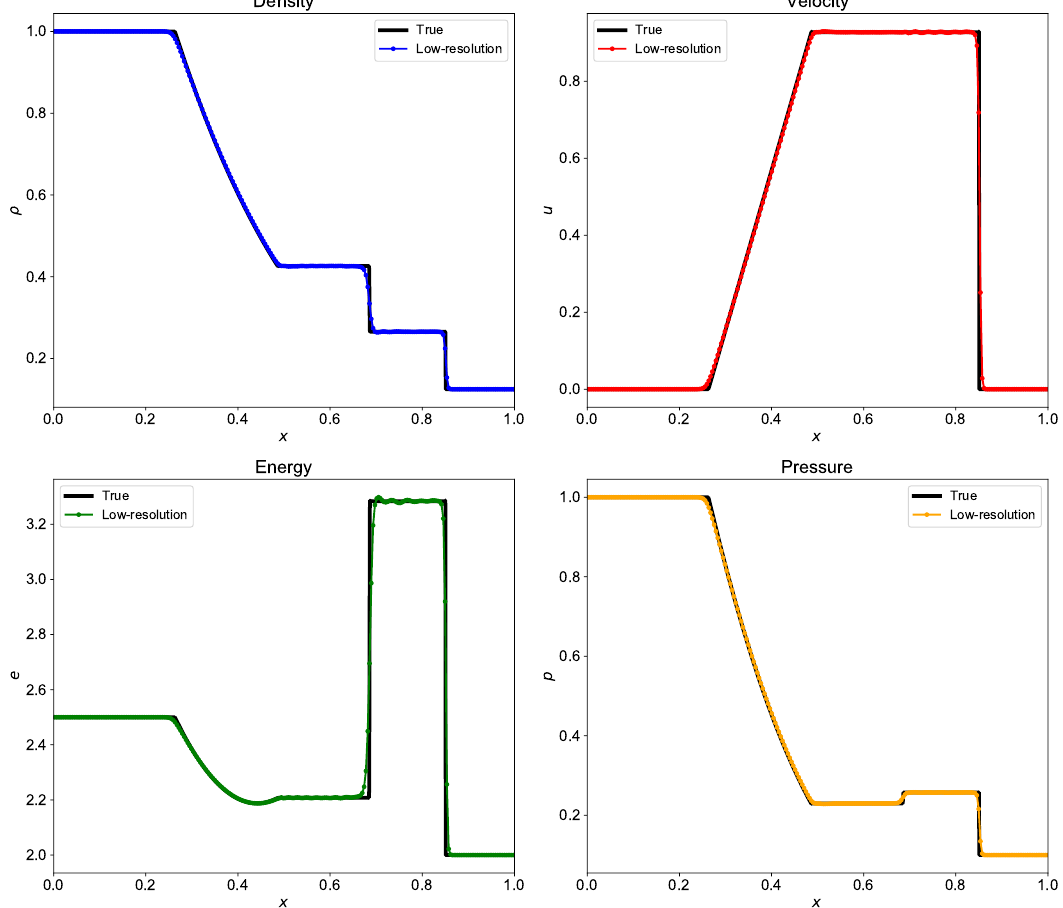
Figure 13. Evolution of density, velocity, energy, and pressure at t = 0.2 for the shock tube problem computed using Riemann solver based on Harten-Lax-van Leer Contact (HLLC) scheme. The true solution is calculated with N = 8192 grid resolution with ∆ t = 0.00005 and the low-resolution results are for N = 256 grid resolution with ∆ t =